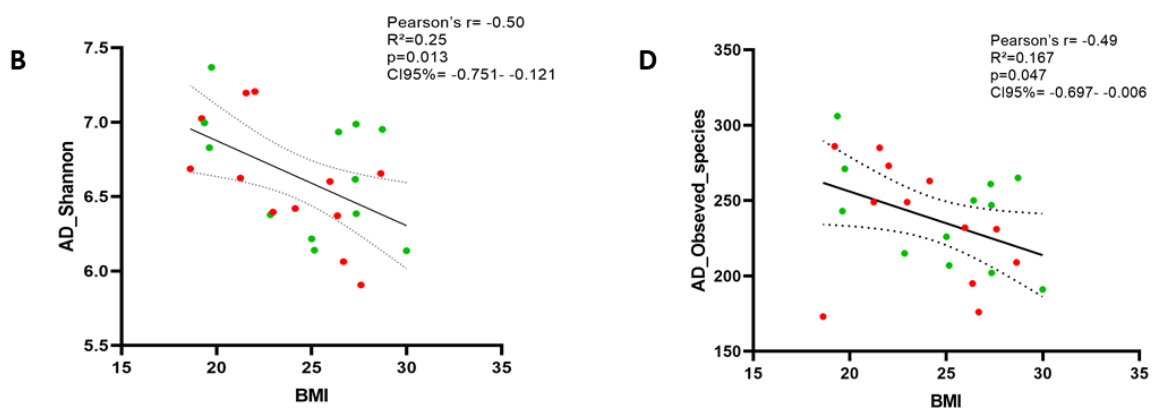
Figure 5. Oxygen consumption (VO 2 peak) and Body Mass Index (BMI) were associated with gut bacteria richness. Figures ( A ) and ( C ) present associations with Shannon index and figures ( B ) and ( D ) show associations with Observed_species. Red points in the graph refer to control subjects while green points represent exercise subjects.